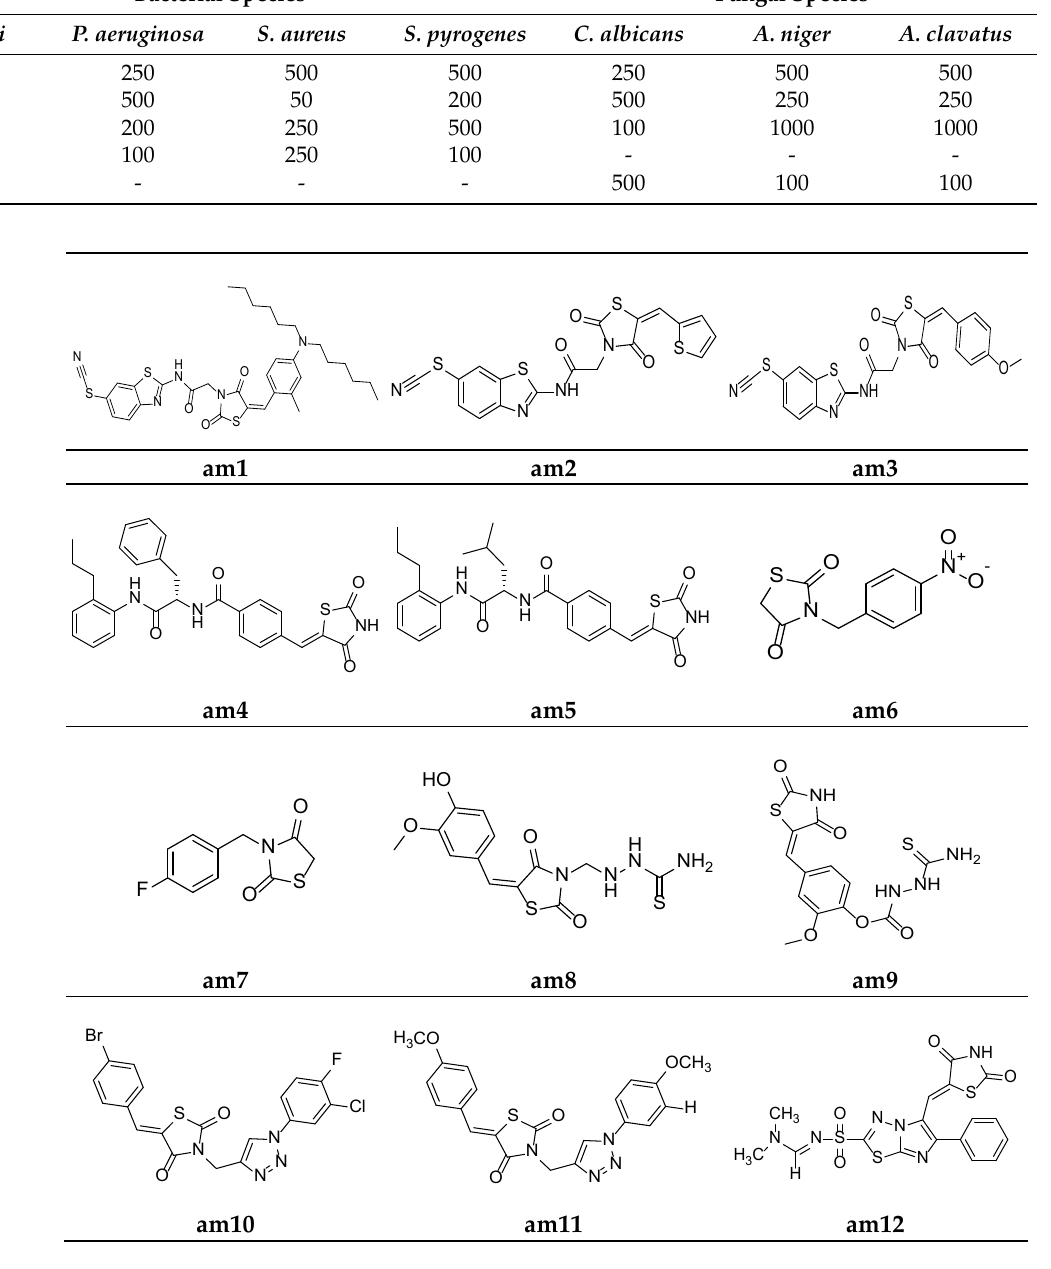
Figure 9. Molecular structures of the compounds ( am1 – am12 ). Table 3. Antimicrobial results of the compounds ( am4 – am5